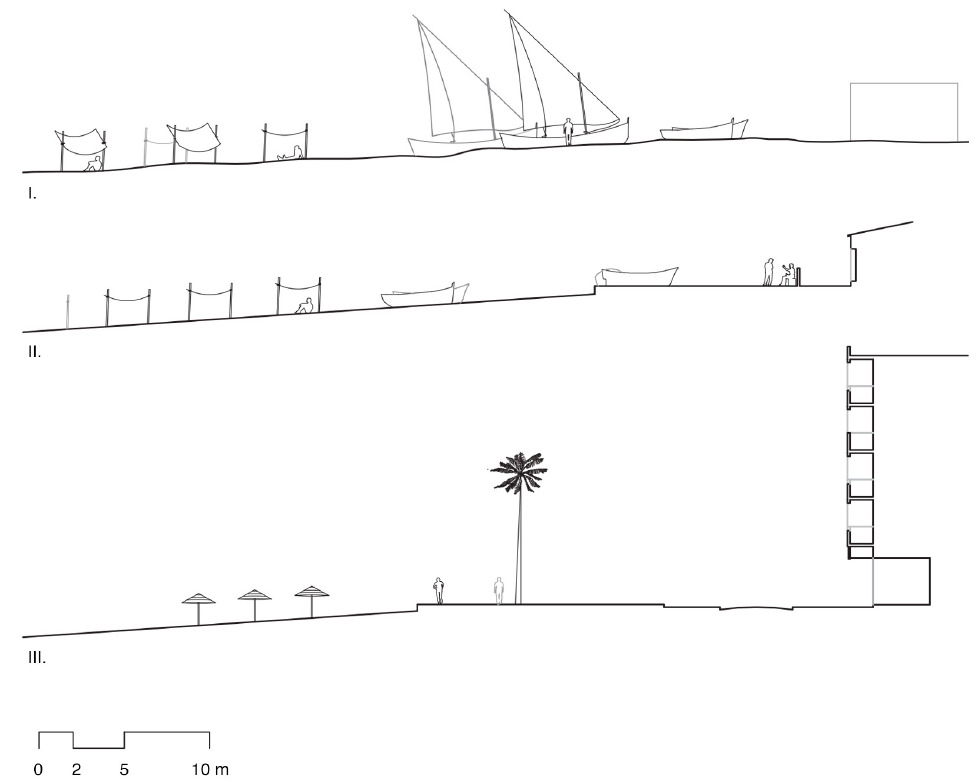
Figure 5. Quarteira. Morphological evolution: sections ( I ) 1930, ( II ) 1960, ( III ) 1970-80. Cartographic bases provided by Câmara Municipal de Loulé. Authors’ edition, 2022.